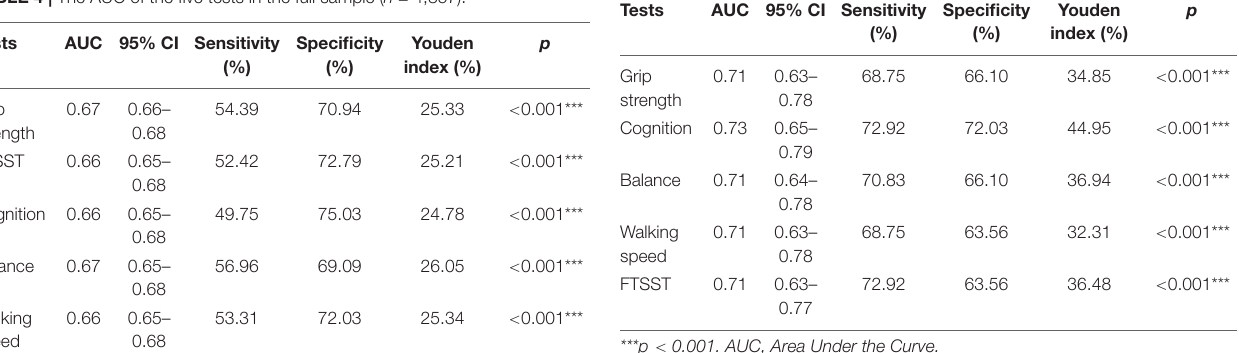
FIGURE 2 | ROC curves of the five tests in the full sample ( n = 4,857). TABLE 4 | The AUC of the five tests in the full sample ( n = 4,857).